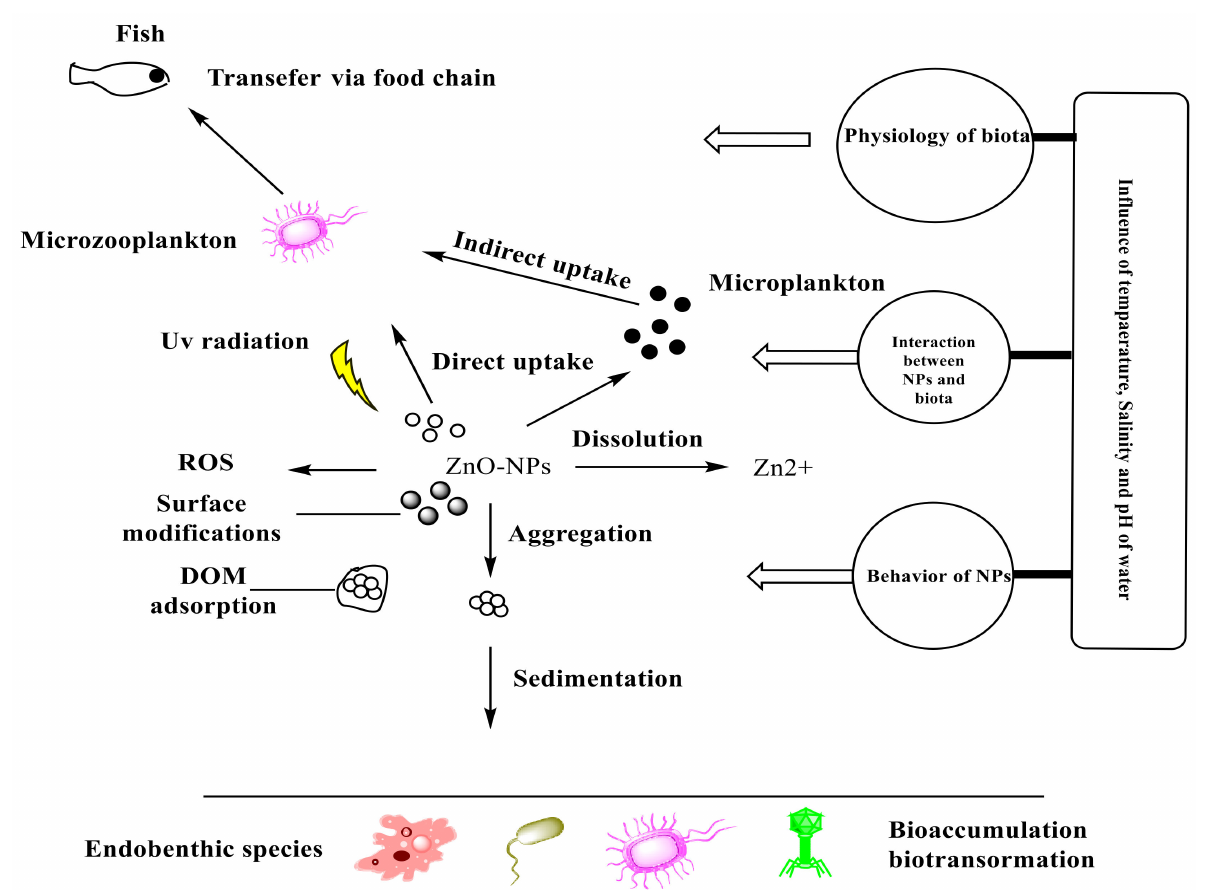
Figure 1. Description of the fate and behavior of ZnO-NPs in the marine